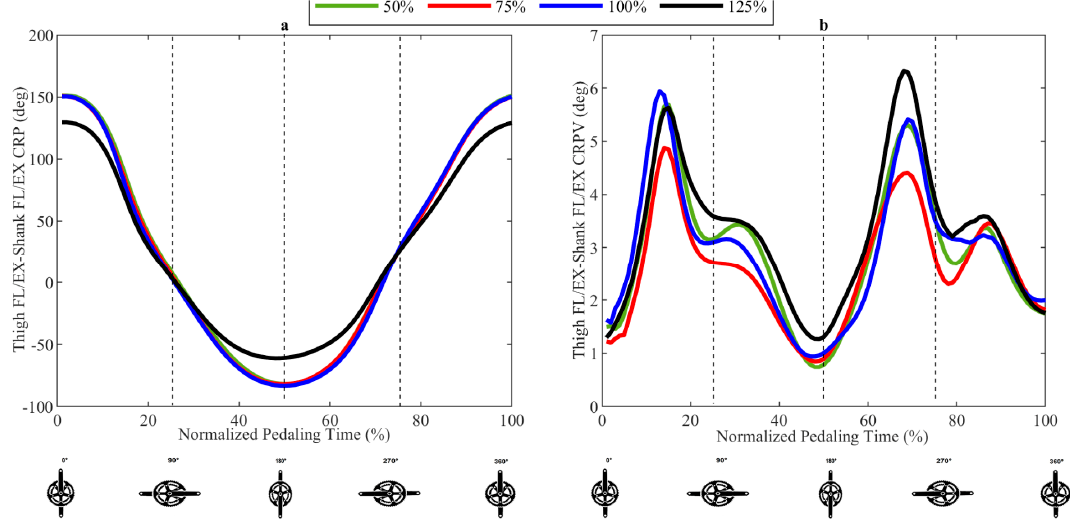
Figure 2. Thigh flexion/extension (FL/EX)-Shank FL/EX continuous relative phase (CRP) ( a ) and continuous relative phase variability (CRPV) ( b ) in different pedaling intensities.